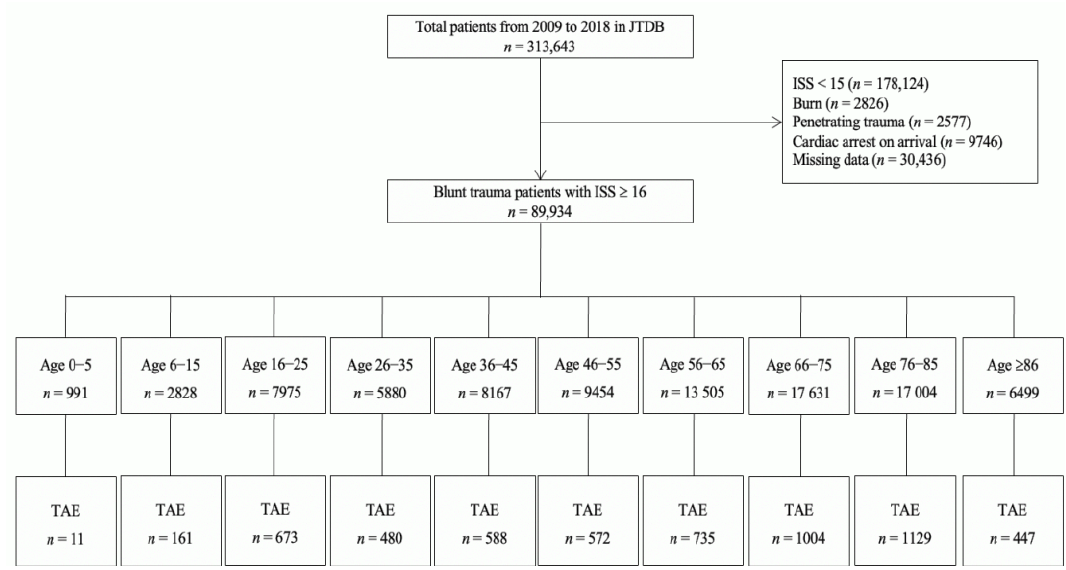
Figure 1. Flow diagram of the study patient disposition. JTDB—Japanese Trauma Data Bank; ISS— Injury Severity Score; TAE—transcatheter arterial